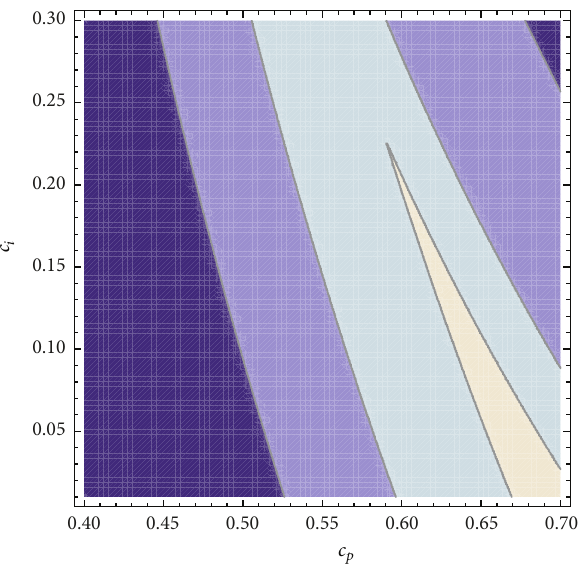
Figure 13: Effective property map for porous SiO 2 coated with Parylene versus volume fractions 𝑐 𝑝 and 𝑐 𝑖 of pores and coating layer,respectively. PropertiesofthecomponentsaregiveninTable 2. Regions with 𝑘 ∗ < 1.8 , 𝐸 ∗ > 12 GPa (yellow), 𝑘 ∗ < 2.0 , 𝐸 ∗ > 10 GPa (light blue), 𝑘 ∗ < 2.2 , 𝐸 ∗ ≤ 5 GPa (blue), and 𝑘 ∗ ≥ 2.2 , 𝐸 ∗ ≤ 5 PGa (dark